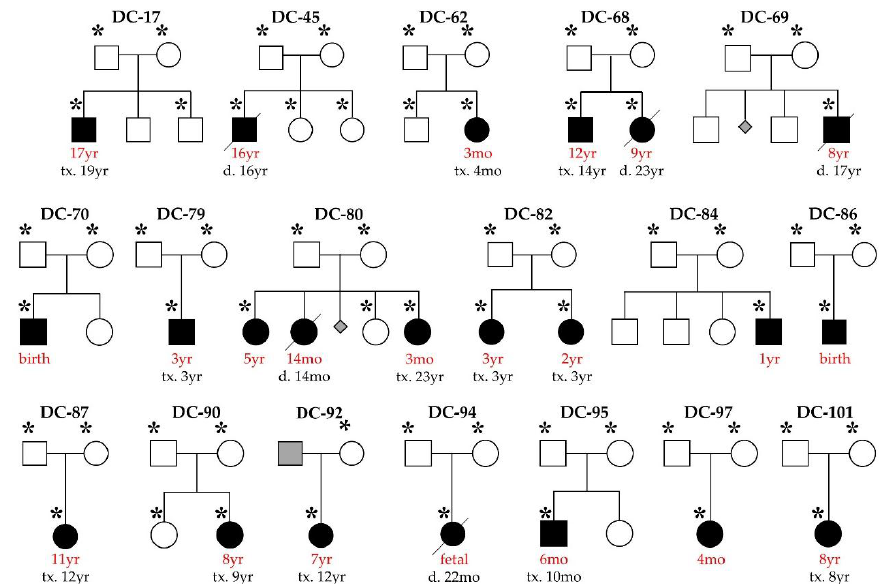
Figure 1. Pediatric dilated cardiomyopathy (DCM) cohort. Square, male; circle, female; black, affected; white, unaffected; grey, unknown; triangle, miscarriage; red font, age at diagnosis; slash, deceased; asterisk, whole exome sequencing (WES) performed. Causal mutations were previously reported in kindreds DC-82, DC-86, DC-87, and DC-94. These families were excluded from the current study except for determination of WES diagnostic yield.